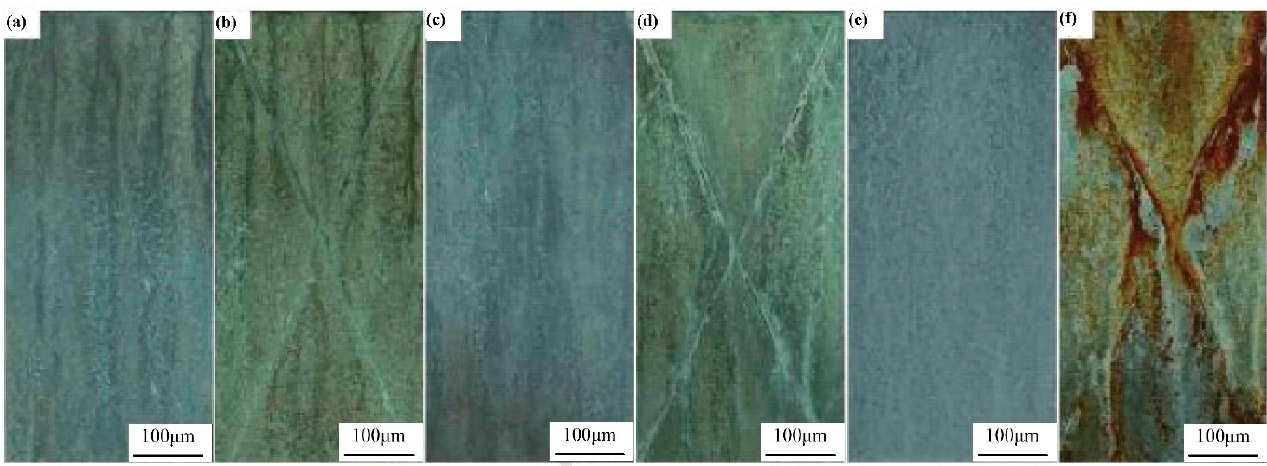
Figure 8. The neutral salt spray test of the Al 0.7 FeCoCrNiCu 1.00 coating samples. ( a , b ) 1440 h; ( c , d ) 2880 h; ( e ) 4320 h; ( f ) 5040 h.